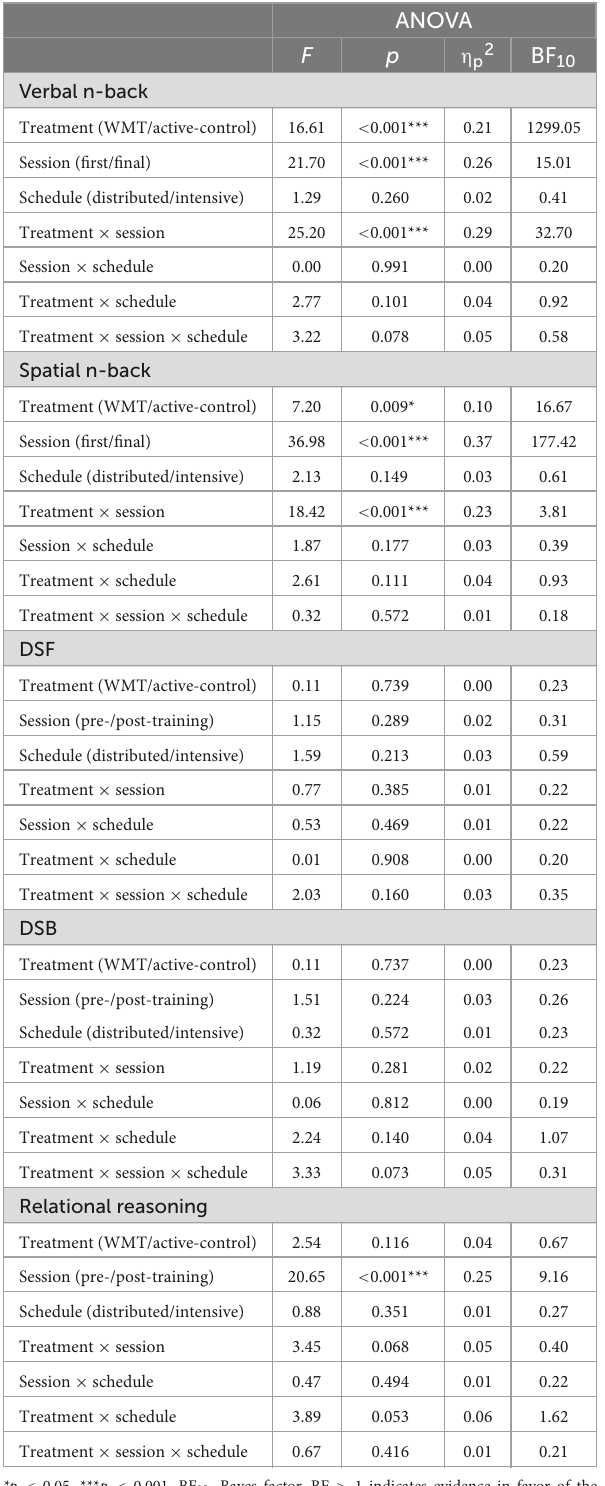
TABLE 2 WMT and transfer task performance: inferential statistics.